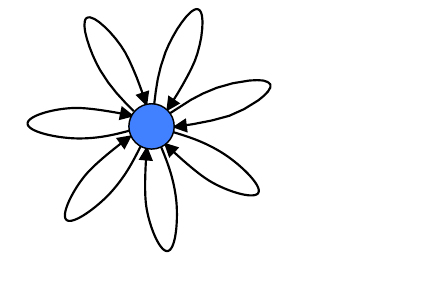
Figure 39. Quiver for the genus 2 BFT obtained by backreacting an instanton on face 4 of phase 2 of dP 2